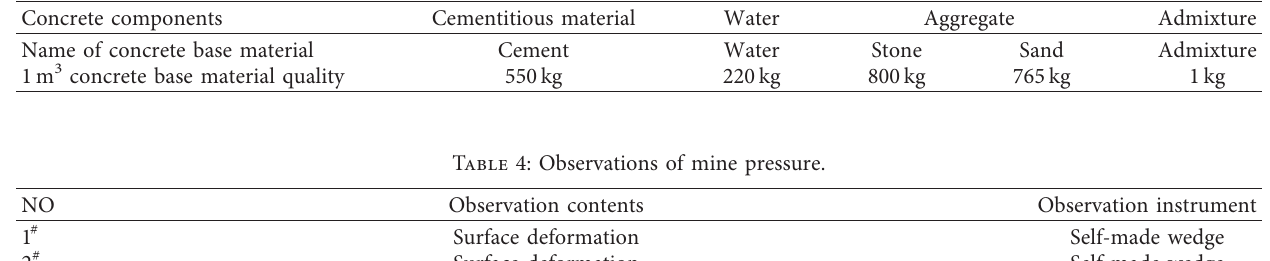
Table 3: The parameters of pump injected concrete.